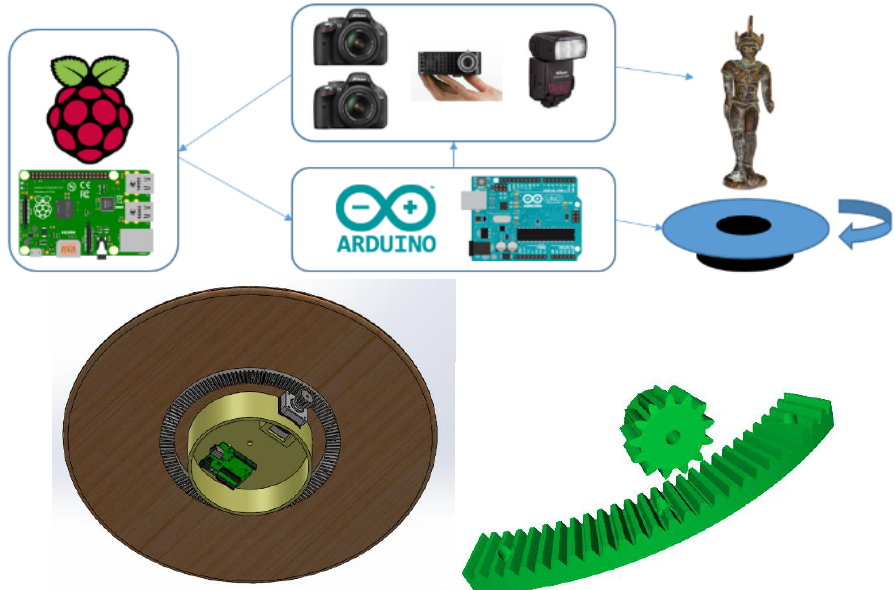
Figure 2. ORION main hardware components and a schematic representation of hardware relationships (up). 3D printed models of the designed parts for the turn table (below).